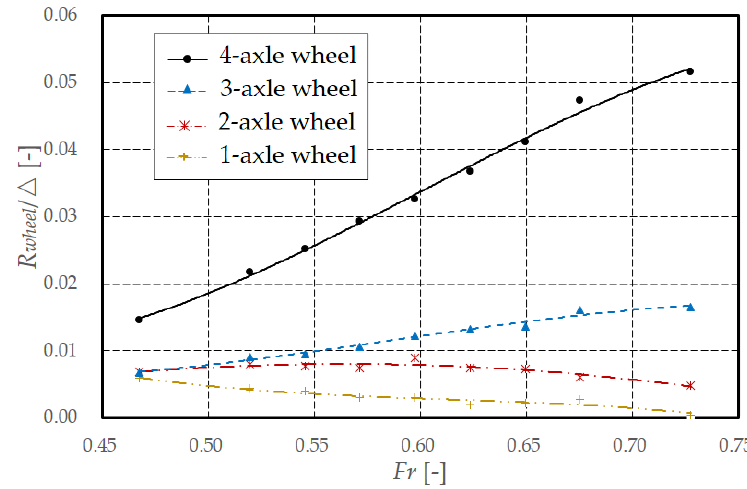
Figure 15. The resistance of the wheels of the TS model at Fr =